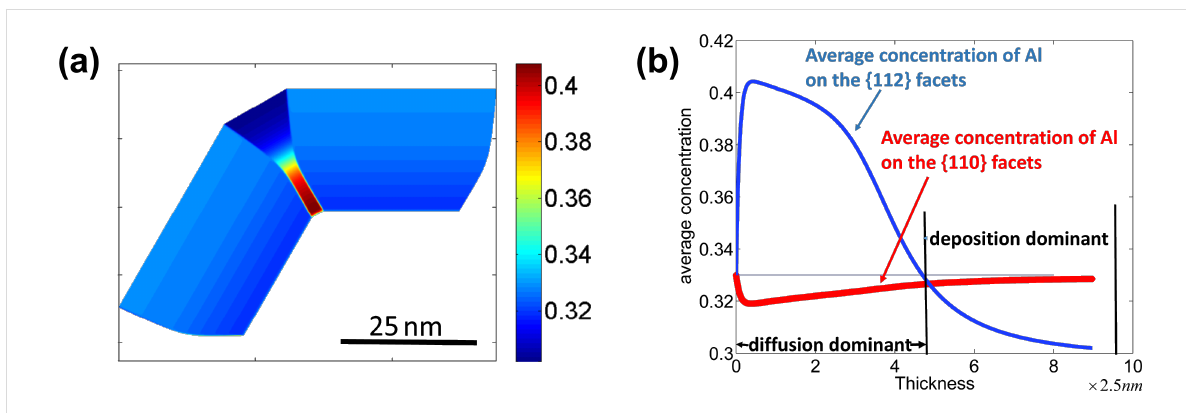
Figure 10: (a) Distribution of the concentration of Al in the shell of the nanowire. (b) Evolution of the average concentration of Al on different facets with the thickness of the shell (in the direction normal to {110} facets).